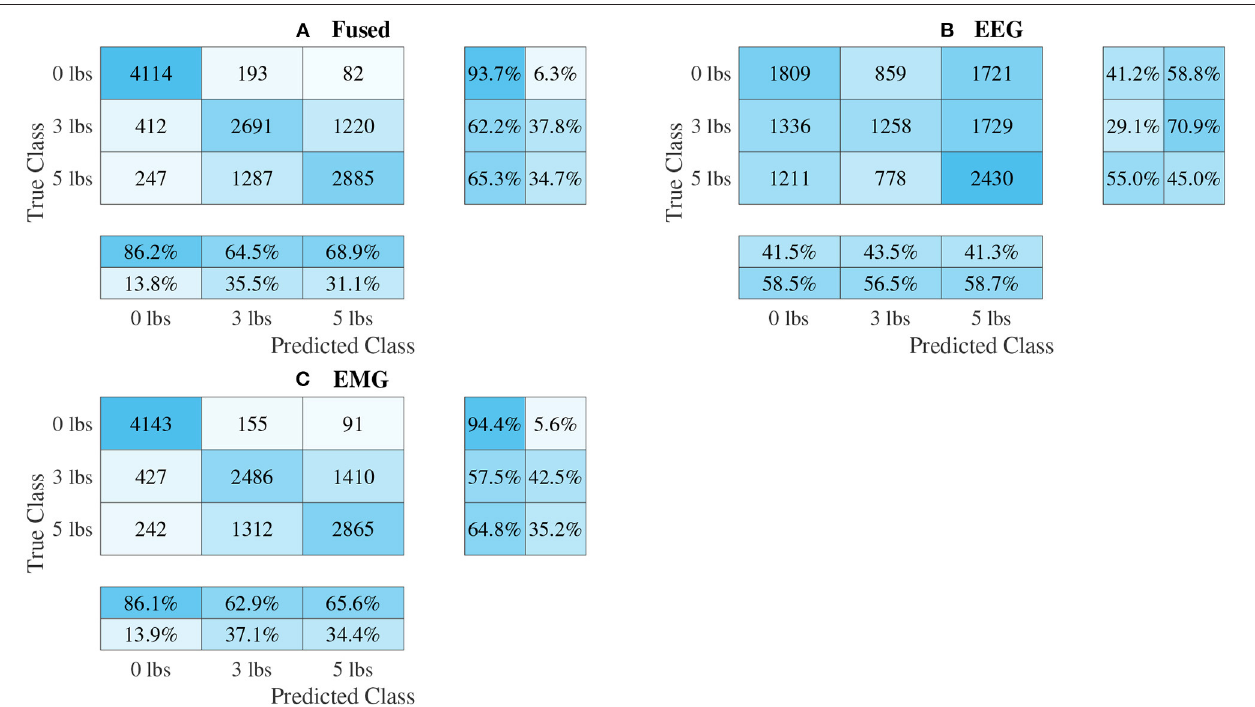
FIGURE 11 | Confusion matrices, using the combined classification results for all subjects, for the split convolution signal-image-based CNN models. (A) Shows the matrix for the EEG–EMG fusion model, while (B,C) how the matrices for the EEG and EMG only models, respectively. Each matrix contains a positive/negative precision score summary in the final two rows, and a positive/negative recall score summary in the final two